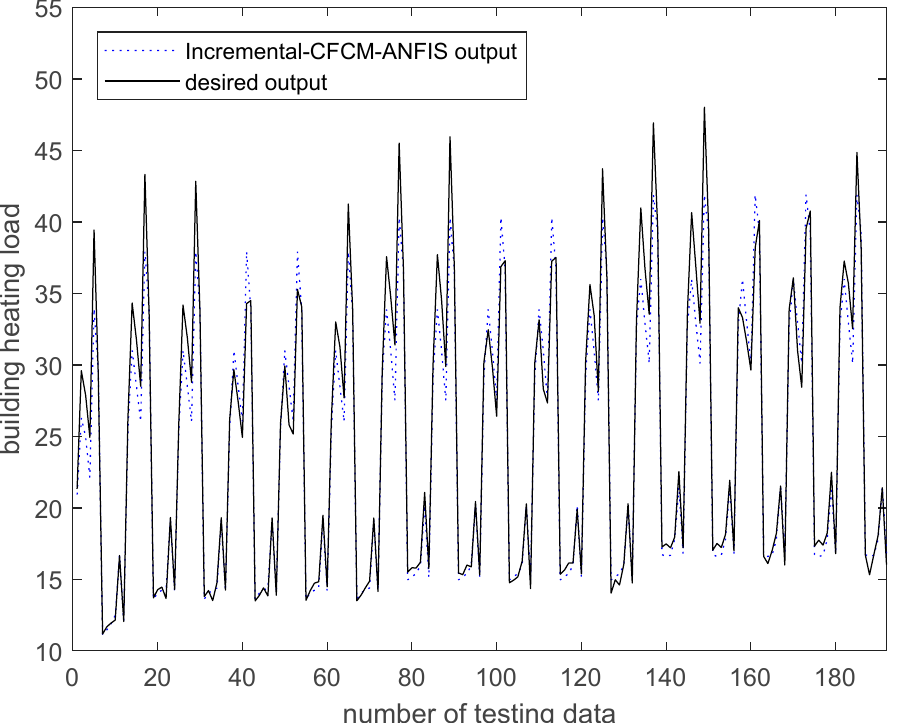
Figure 7. Comparison of the predicted and actual output values of FCM clustering-based ANFIS.